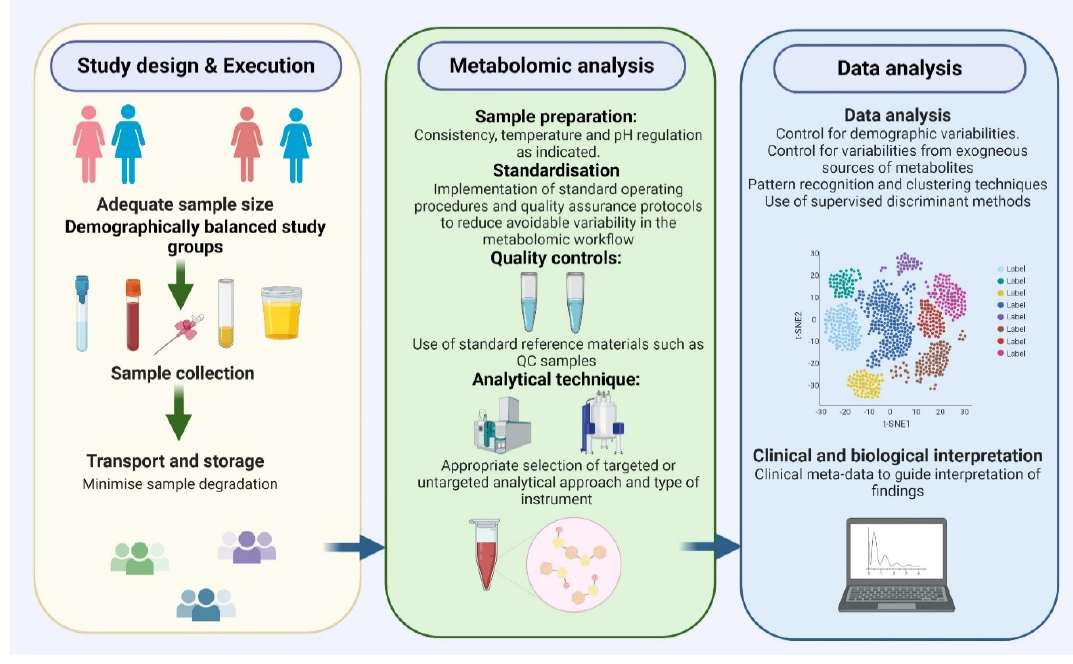
Figure 2. Important considerations for the design of metabolomic biomarker discovery studies. An adequate sample size with demographically balanced study groups, consistency in sample collection, the identification of viable biomarkers for cancer detection, prognosis and monitoring.